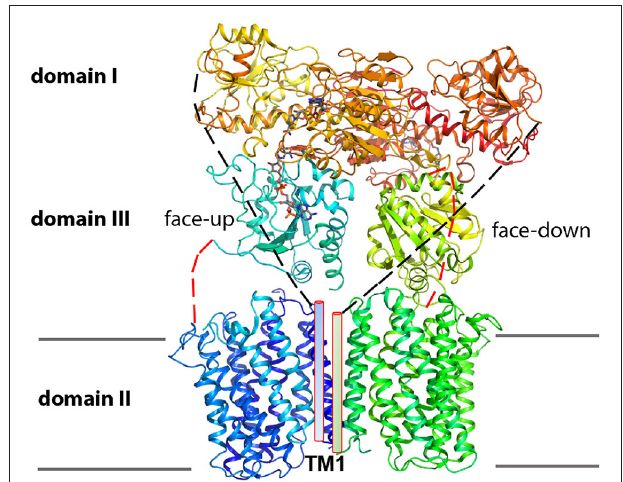
FIGURE 1 | Architecture of holo-TH. TH varies in polypeptide compositions in different species but displays an overall conserved domain architecture. The cartoon is based on a holo-TH crystal structure from T. thermophilus (PDB: 4O9U), shown as a dimer with three domains. Domain I and domain III protrude from membrane-intercalated domain II (membrane boundaries in gray line), with domain III placed in the middle. A linker of 14–19 amino acids (red dashed lines), which is not revealed in 4O9U, connects domain II and III in all TH homologs. Domain I is expressed as a single polypeptide in T. thermophilus , but in mitochondrial TH it is fused with domain II through a linker (black dashed lines) and an additional TM1